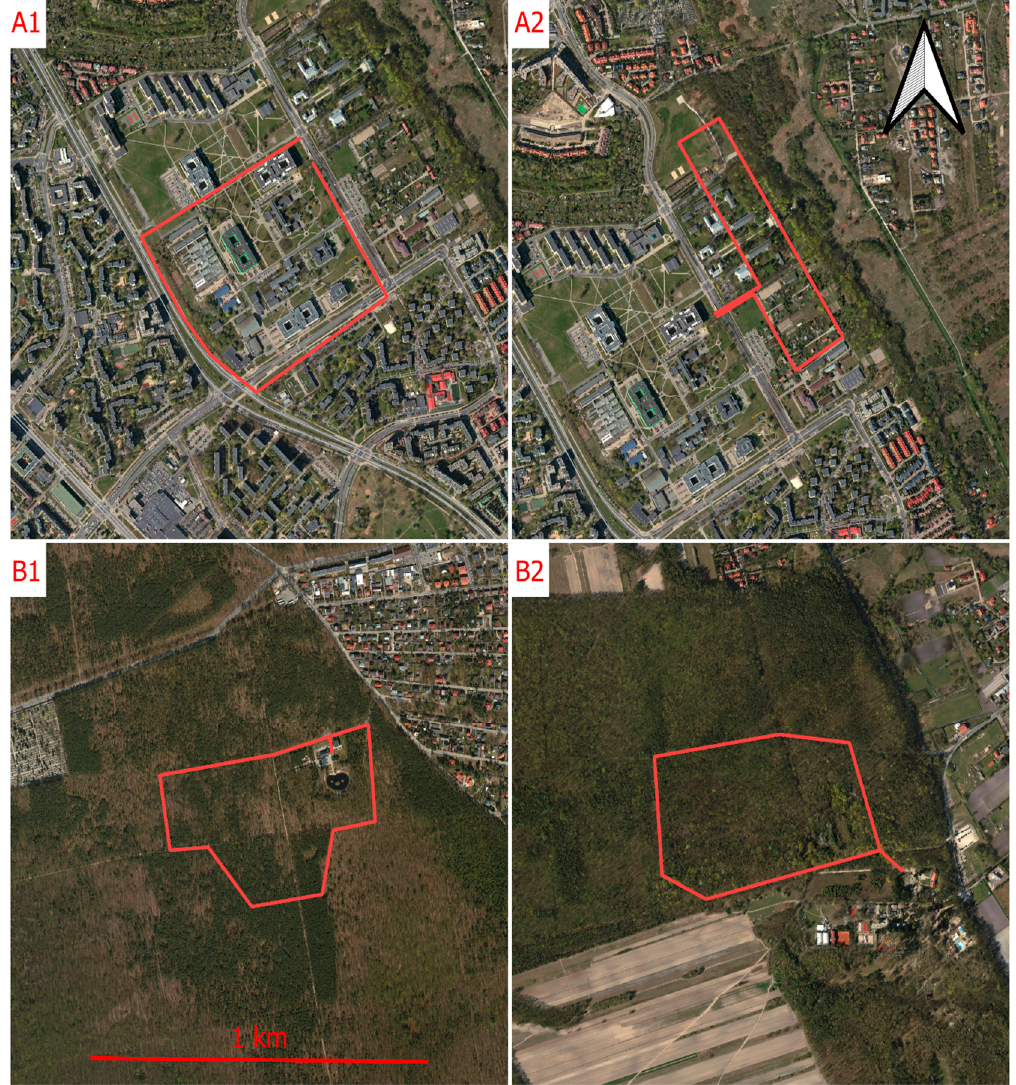
Figure 1. The map of experimental locations: ( A1 ) apartment suburbs, ( A2 ) green suburbs, ( B1 ) Figure coniferous forest, ( B2 ) deciduous forest.